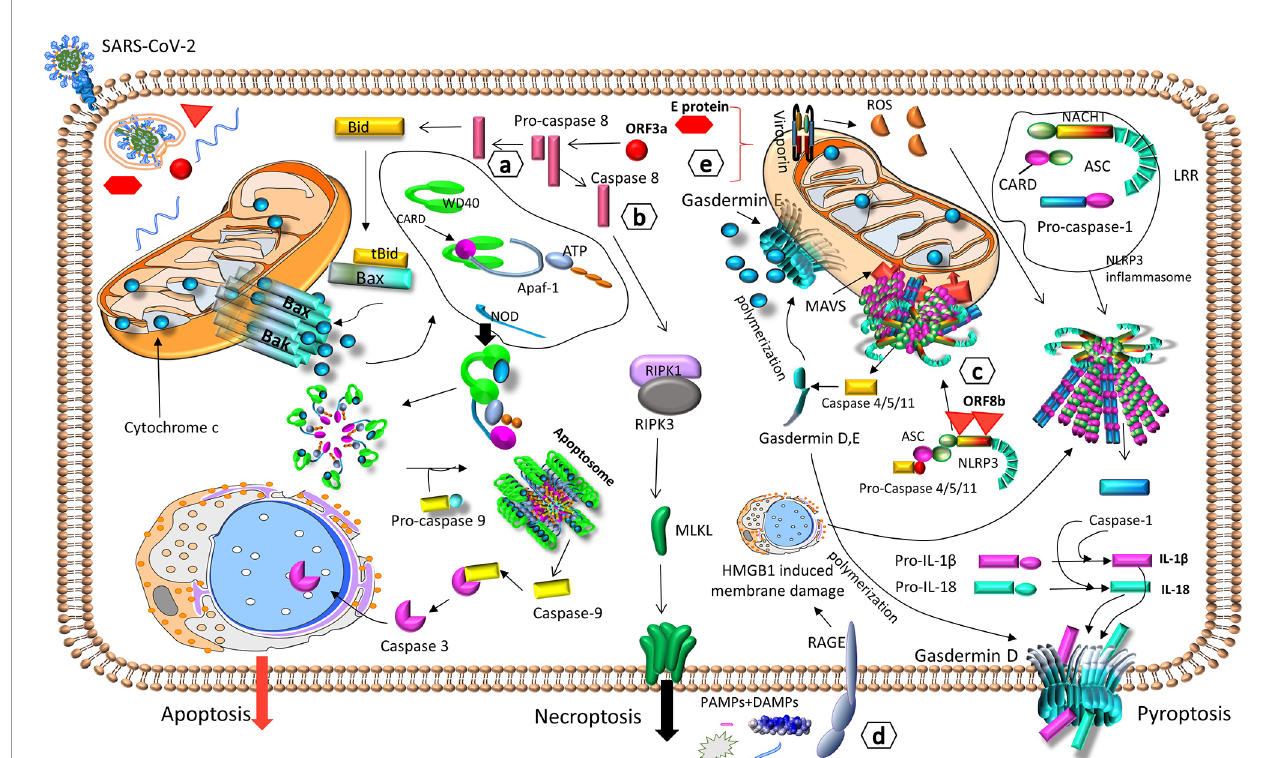
FIGURE 5 | SARS-CoV-2 can trigger different types of cell death. SARS-CoV-2 induces cell death and destruction of target cells via a) apoptosis, through caspase 8-BID/tBID-cytochrome c-caspase 9 (104), b) necroptosis, through caspase 8-RIPK1-RIPK3-MLKL (33), c) pyroptosis, through NLRP3-mediated in fl ammasome activation and gasdermin D - caspases-1, -4, -5, -11 (105). All modes of cellular death result in the destruction of infected cells and the release of PAMPs, DAMPs, IL-1 b and IL-18, which activate the innate immune response (33, 104, 105), d) PAMPs and DAMPs from damaged cells, can also be detected by the receptor of RAGE, which triggers HMGB1-induced membrane damage, NLRP3-mediated in fl ammasome activation, and pyroptosis (106). e) During intracellular viral replication, the viral proteins ORF3a and E, form viroporins, that augment ROS production, NLRP3-mediated in fl ammasome activation, and pyroptosis (107). Apaf-1, apoptotic protease activating factor 1; ASC, apoptosis-associated speck-like protein containing a CARD; ATP, adenosine triphosphate; Bac, Bcl-2 homologous antagonist/ killer; Bax, Bcl-2-associated X protein; BID/tBID, BH3-interacting domain death agonist/truncated BID; CARD, caspase activation and recruitment domain; DAMPs, damage-associated molecular patterns; HMGB1, high mobility group box 1; IL, interleukin; LRR, leucine-rich repeat; MAVS, mitochondrial antiviral-signaling protein; MLKL, Mixed lineage kinase domain like; NACHT, NACHT domain; NLRP3, NOD-Like Receptor family pyrin domain containing 3; NOD, Nucleotide-binding Oligomerization Domain; PAMPs, pathogen-associated molecular patterns; RAGE, receptor of advanced glycation end products; RIPK, Receptor-interacting serine/ threonine-protein kinase; ROS, reactive oxygen species; WD40, WD40